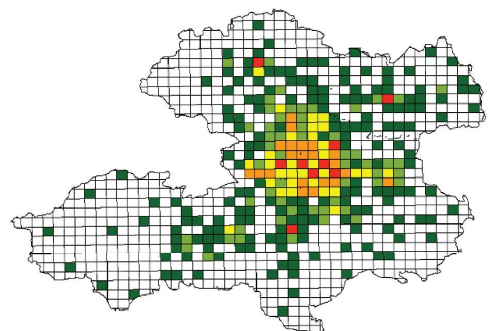
Figure 17: Distribution of